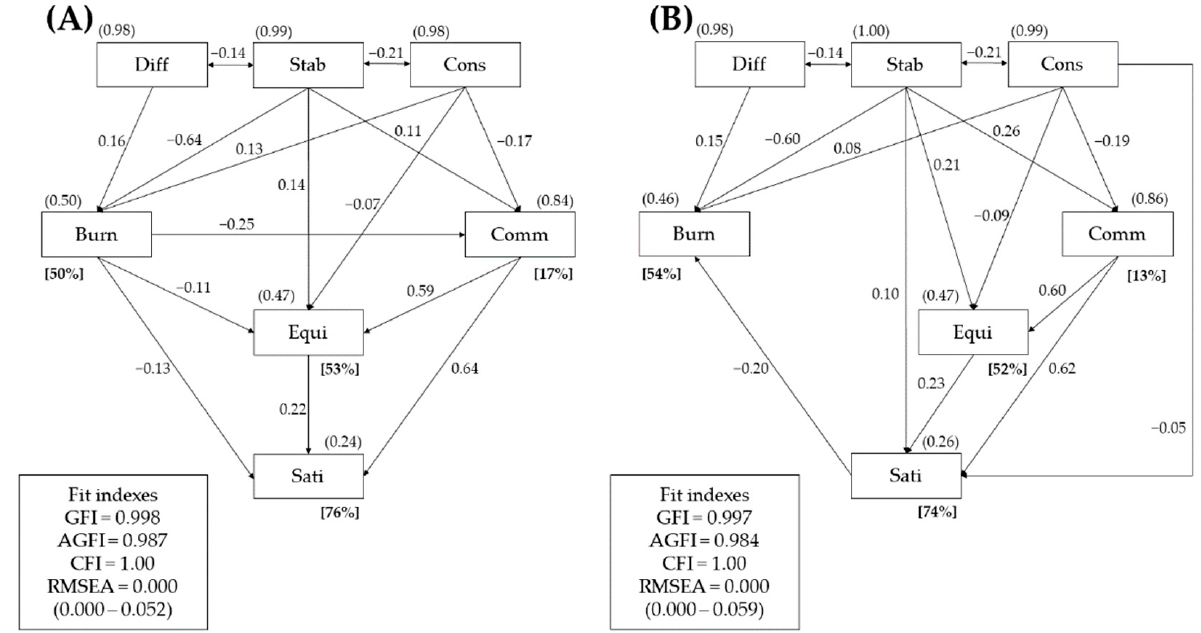
Figure 2. Final reduced versions of the mail ( A ) and alternative ( B ) path models for mothers of chil-